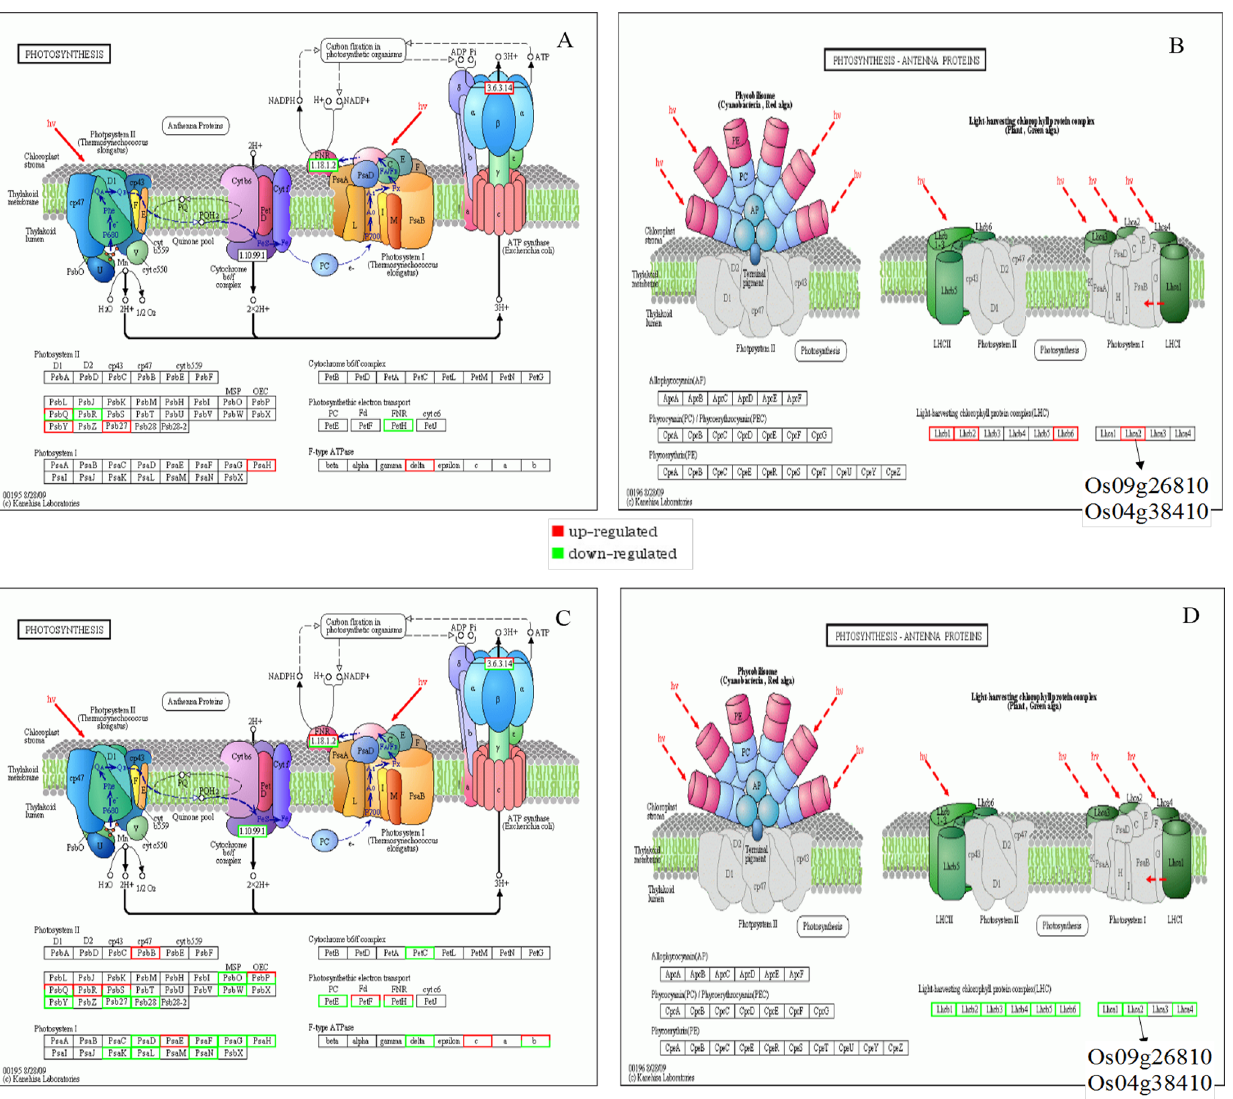
Figure 1. The pathway analysis of photosynthesis (A and C) and photosynthesis-antenna proteins (B and D) of Zn-sensitive rice ( Oryza sativa L.) cultivar grown hydroponically with either normal (0.15 m M) or high (2 mM) Zn without or with 1.5 mM Si for 72 h through high-throughput